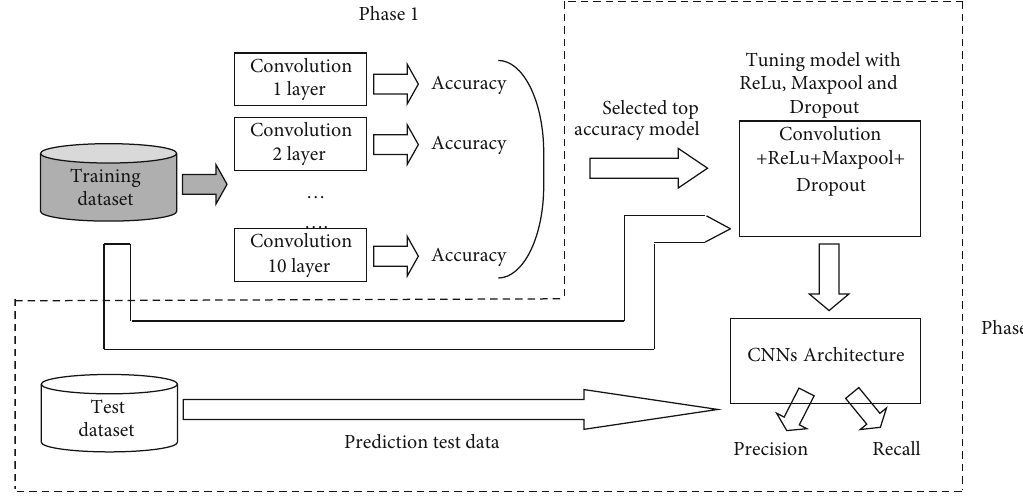
Figure 3: The proposed deep learning for parasite